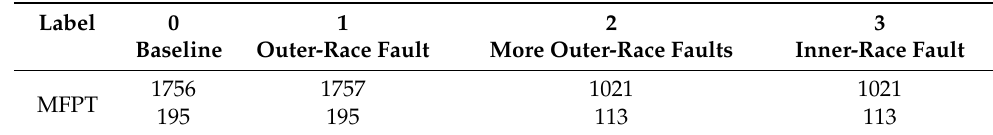
Table 6. MFPT dataset.